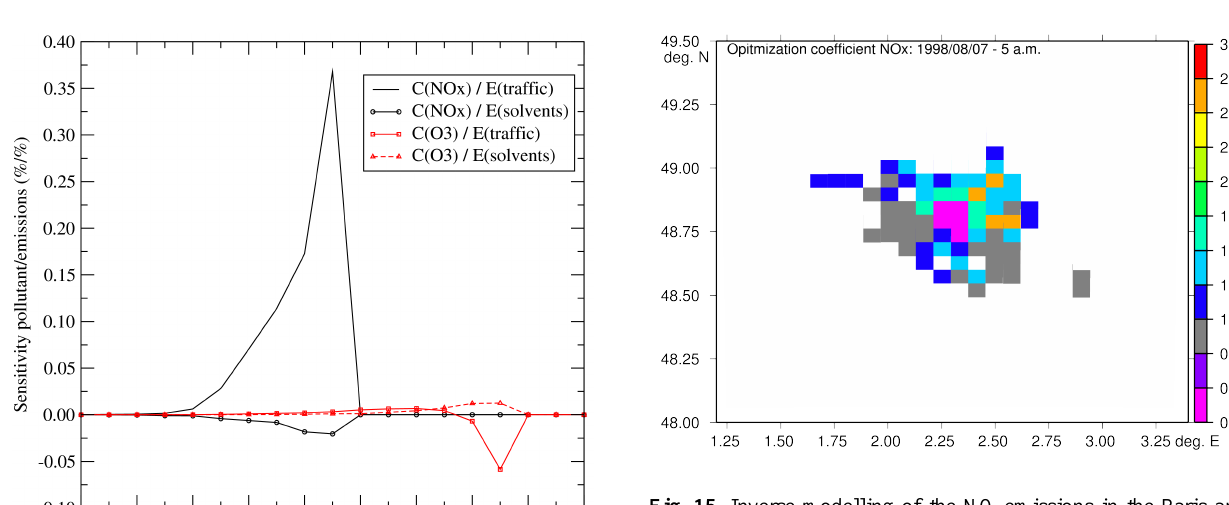
Fig. 15. Inverse modeling of the NO emissions in the Paris area for August, 7 1998 (ESQUIF campaign). The results are multiplicative factors to apply to the emissions flux hour by hour. A value of 1 means there is no change to apply to the fluxes, when, for example, a value of 0.5 means it is needed to divide by two the NO emissions fluxes to reduce the differences between the measured and modeled surface concentrations of NO x .